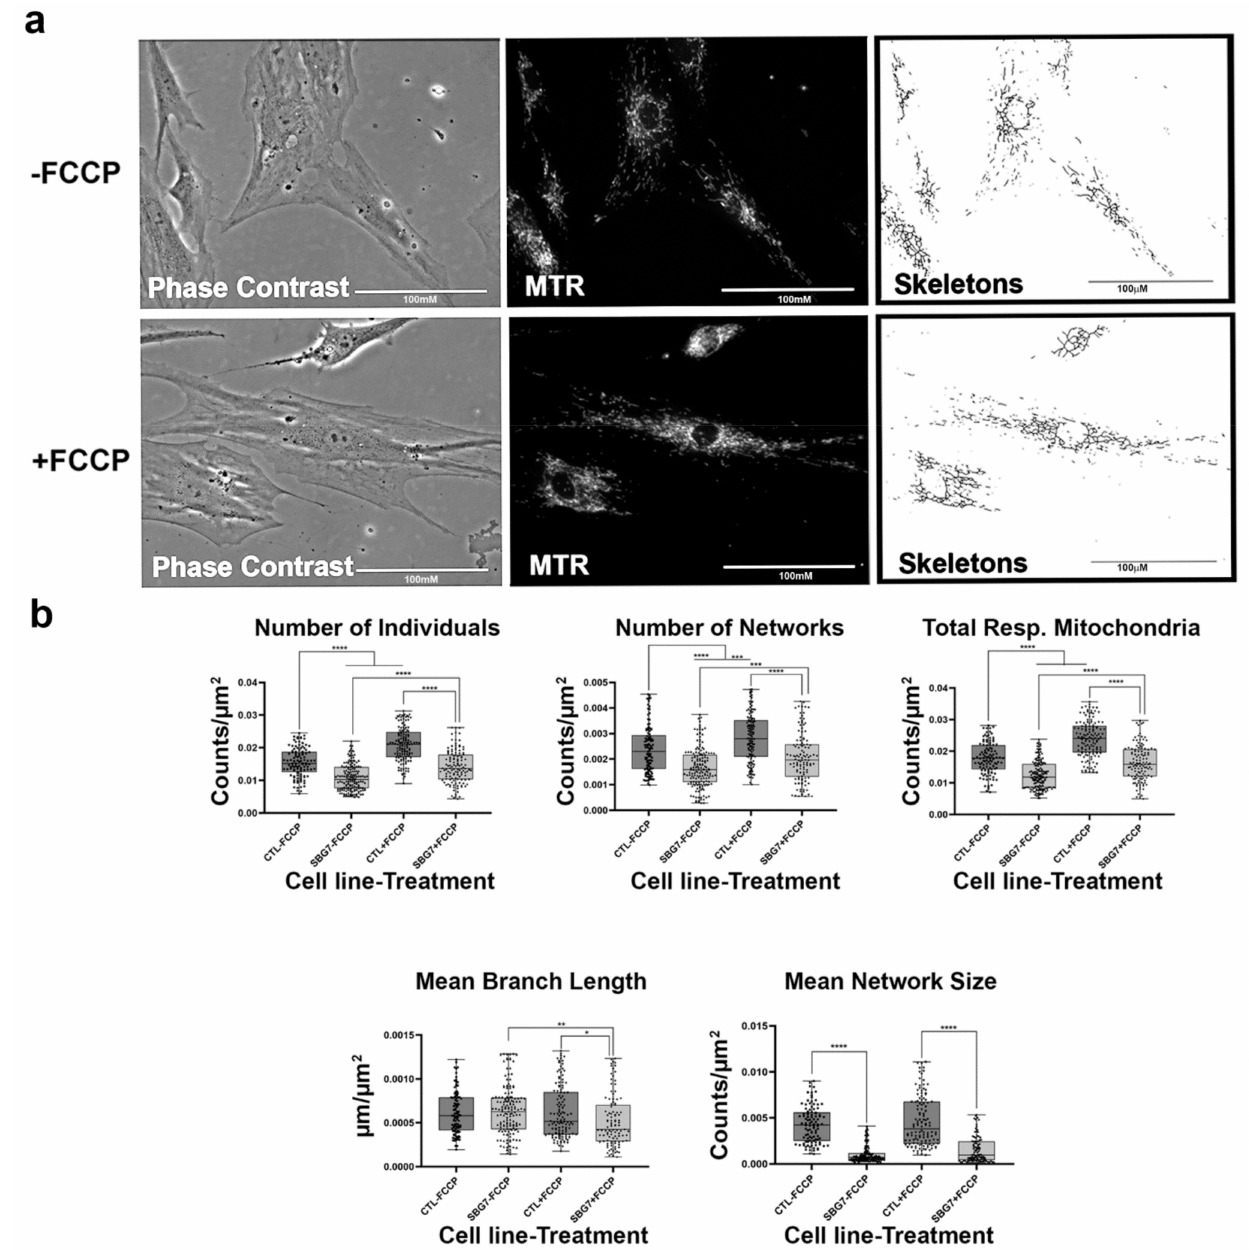
Figure 9. Mitochondrial morphology of SBG7 fibroblast in the absence and presence of FCCP. ( a ) Representative images of SBG7 fibroblast cell lines stained with MTR. The top images are phase contrast, RFP, and skeletonized images of SBG7 fibroblasts without FCCP treatment. The bottom images are phase contrast, RFP, and skeletonized images of SBG7 fibroblasts with FCCP treatment. ( b ) The SBG7 fibroblasts have significantly fewer networks of actively respiring mitochondria relative to the control BJ fibroblasts. FCCP treatment resulted in fragmented mitochondria in the SBG7 fibroblasts with mean network size trended towards an increase upon treatment. All data are representative of 10–14 images taken from three independent dishes per treatment group. The bars represent minimum and maximal values, and each black dot represents different data points. **** p < 0.0001, *** p < 0.001, ** p < 0.01, * p < 0.05. Scale bar = 100 µ